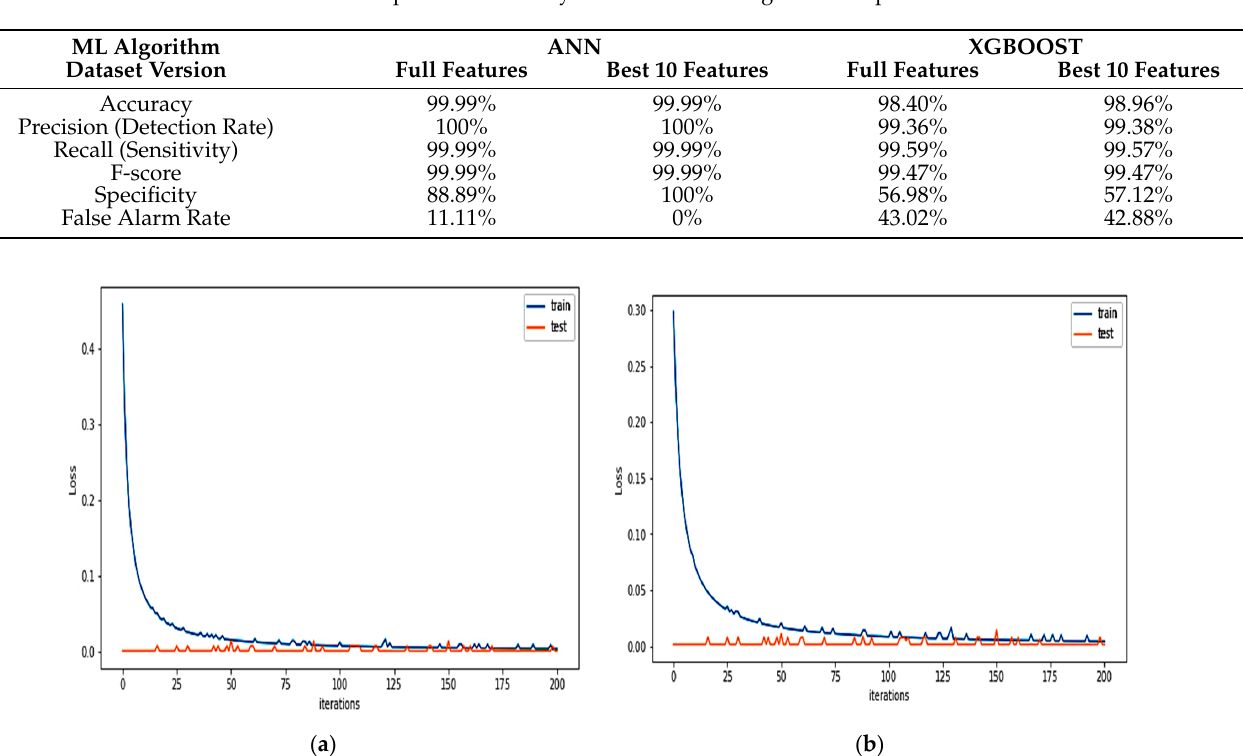
( b ) Figure 8. Losses in testing for each client of the proposed algorithm using: ( a ) BoT-IoT (full features); ( b ) BoT-IoT (best features).